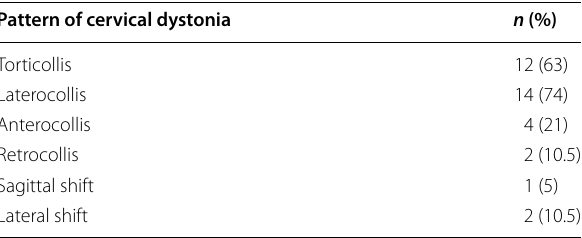
Table 4 Incidence of different patterns of head movement in cervical dystonia observed among the study population Pattern of cervical